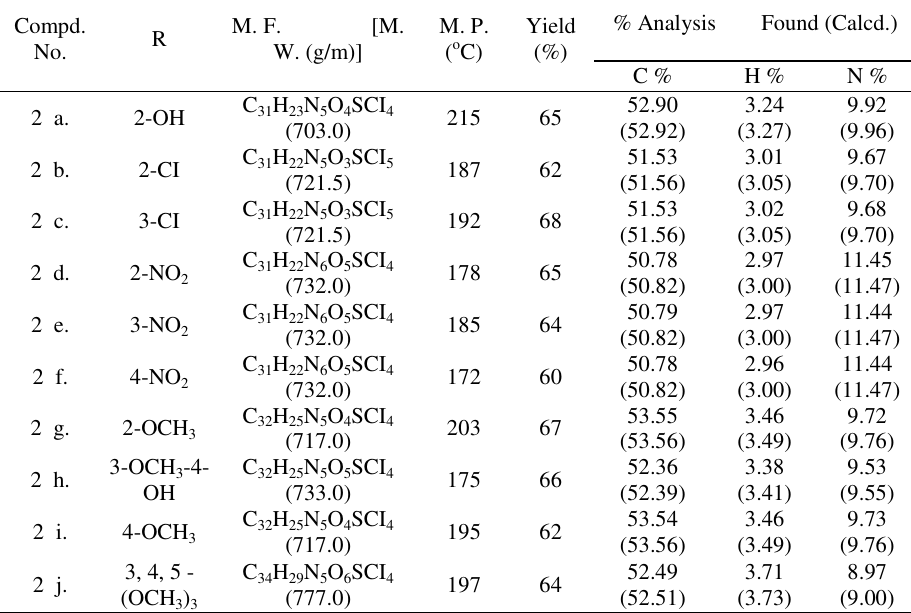
Table 2 . PHYSICAL AND ANALYTICAL DATA OF COMPOUNDS [2(a-j)]